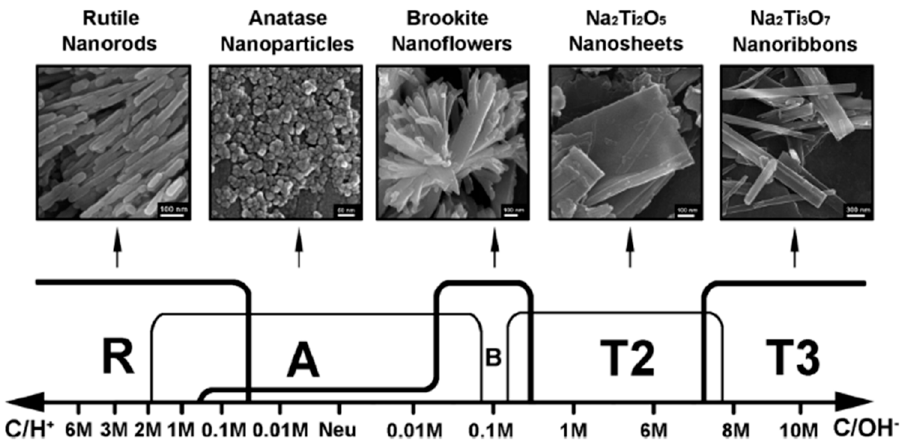
Figure 3. The e ff ect of acid / alkali concentration. Rutile TiO 2 , anatase TiO 2 , brookite TiO 2 , dititanate Na 2 Ti 2 O 5 and trititanate Na 2 Ti 3 O 7 are represented by “R, A, B, T2 and T3”, respectively. Reprinted with permission from Ref. [38] RSC Copyright 2012.